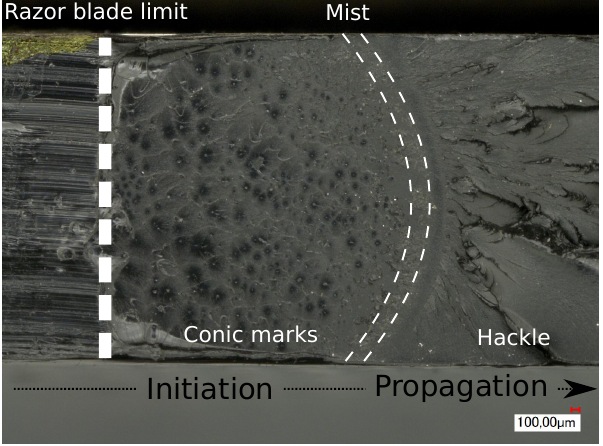
Figure 4. Several zones can be identified (from left to right): the razor blade penetration zone - the conical mark zone - the intermediate "mist" zone - the chaotic "hackle" zone. The arrow indicates the direction of